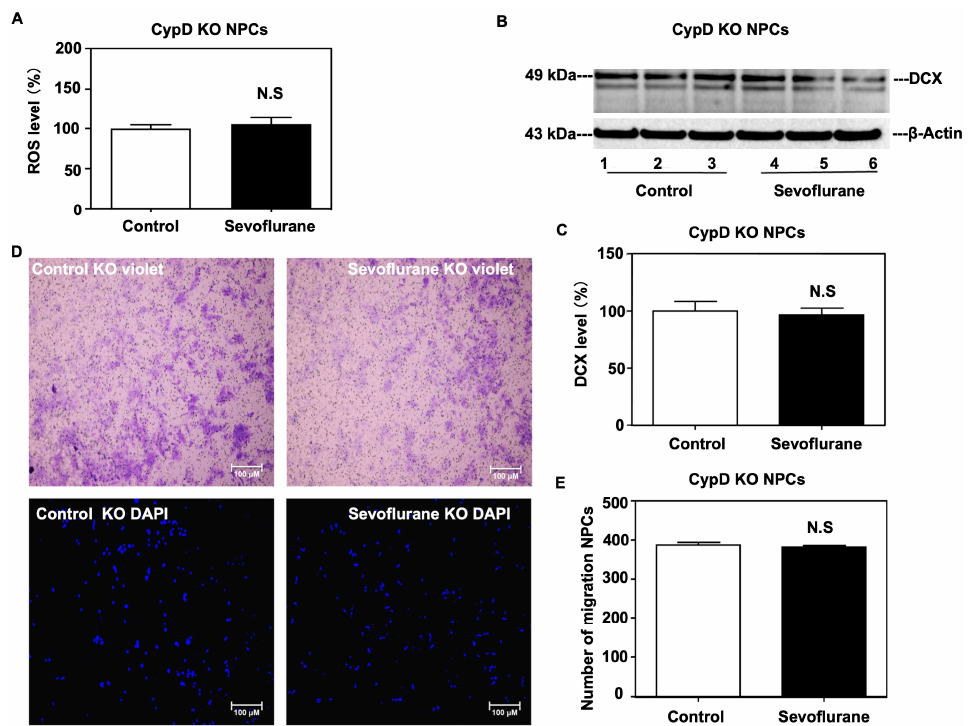
Figure 4. CypD KO mitigates the sevoflurane-induced increases of ROS, decreases of DCX, and inhibition of cell migration in NPCs. ( A ) The sevoflurane treatment does not increase ROS levels compared to the control condition in NPCs harvested from CypD KO mice. Quantitative Western blot ( B , C ) analysis shows that the sevoflurane treatment does not decrease DCX levels compared to the control condition in the NPCs harvested from CypD KO mice. There is no significant difference in β -actin levels between each condition. ( D ) The representative transwell assay images of migrated cell stained by crystal violet (top) or DAPI (below) at 24 h after the sevoflurane treatment. ( E ) Quantification of the transwell assay shows that the sevo fl urane treatment does not signi fi cantly a ff ect the number of migrated NPCs harvested from CypD KO mice compared to the control condition. N = 6–8 in each group. Student’s t -test was used to analyze the data. N.S: non-signi fi cant di ff erences .